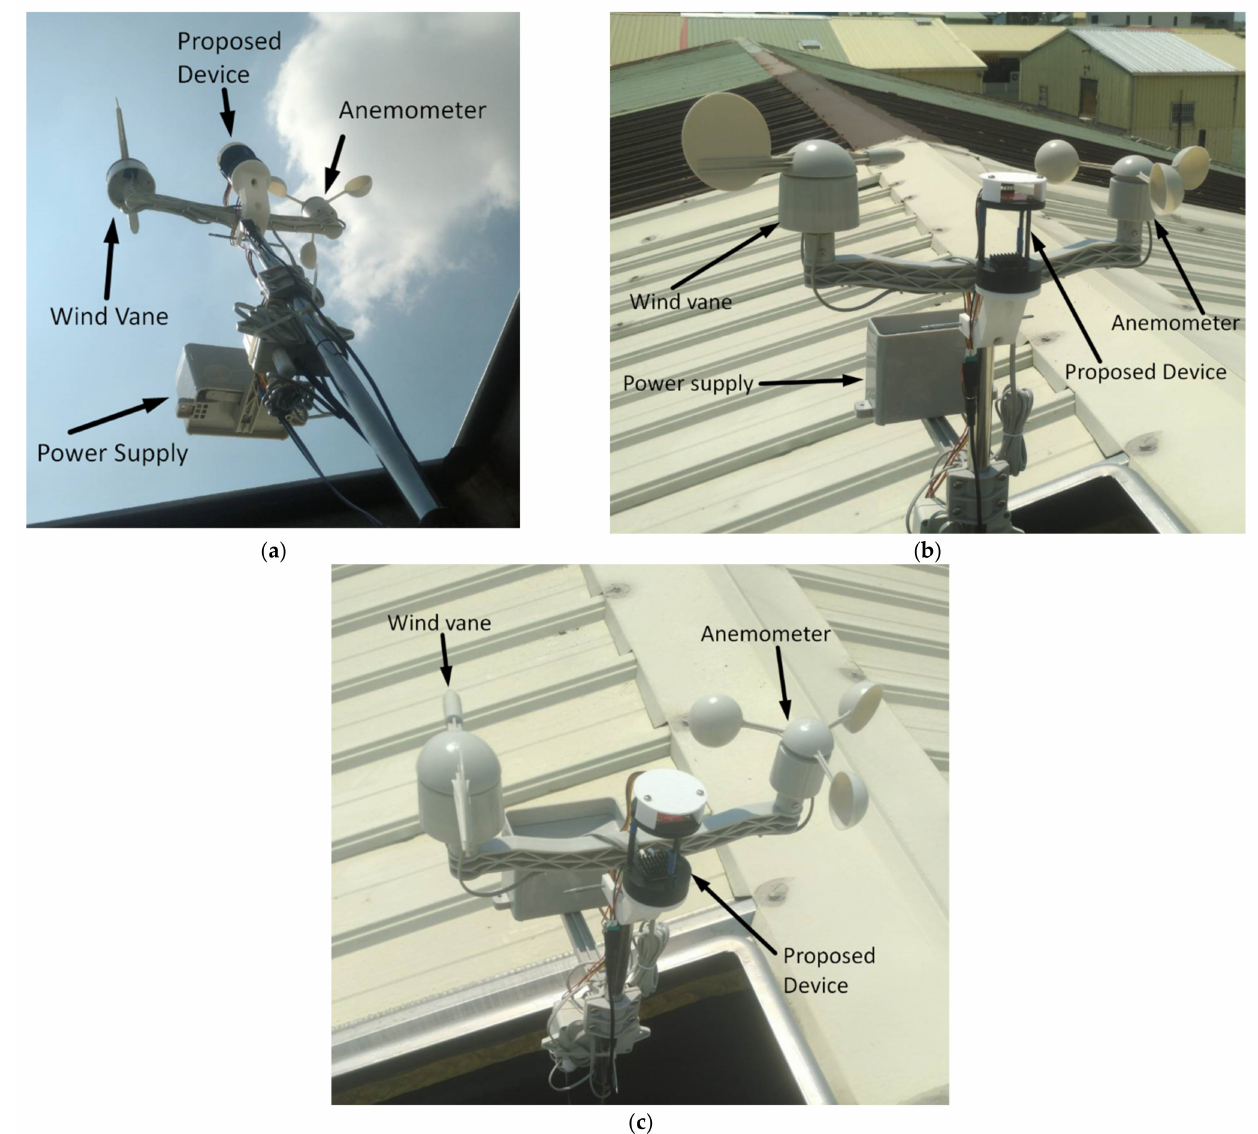
Figure 4. Images of sensors installed for experimental setup. ( a ) Picture taken from below showing the cup anemometer, wind vane and proposed sensing system installed on a vertical pole and ( b ) picture taken from the rooftop showing the positions of different sensors on the fixture. ( c ) Picture taken from the top showing the arrangement of different